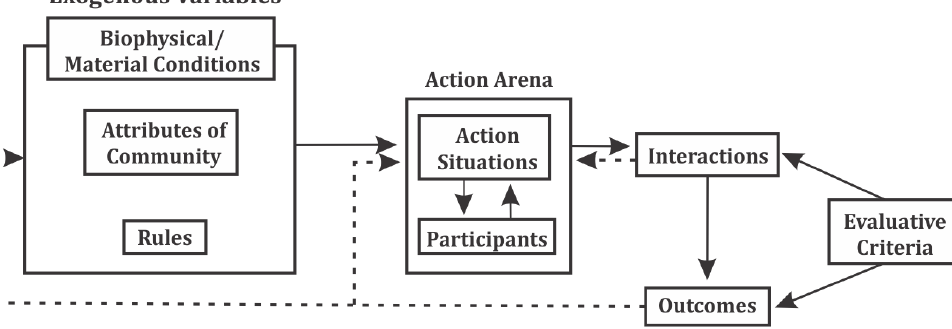
Figure 1. A framework for institutional analysis ( source: [14]).